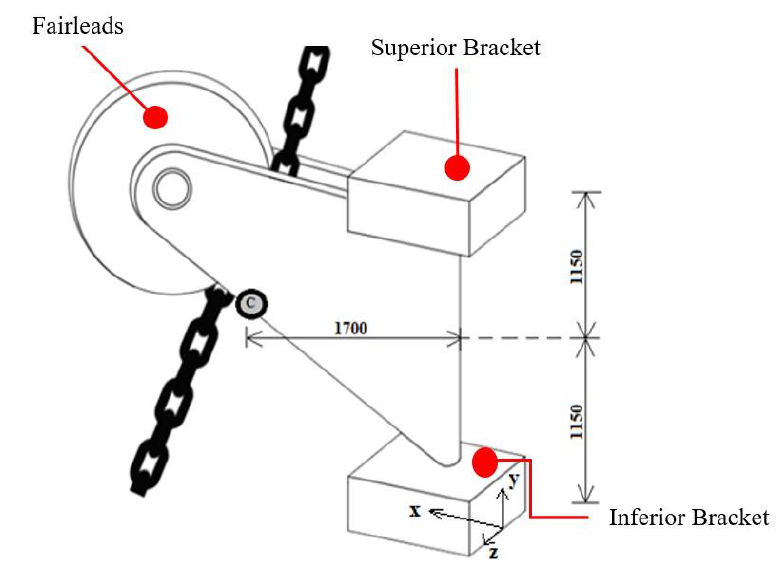
Figure 4. Sketch of the fairlead / bracket set with the position of the centroid of the fairlead (values in mm).